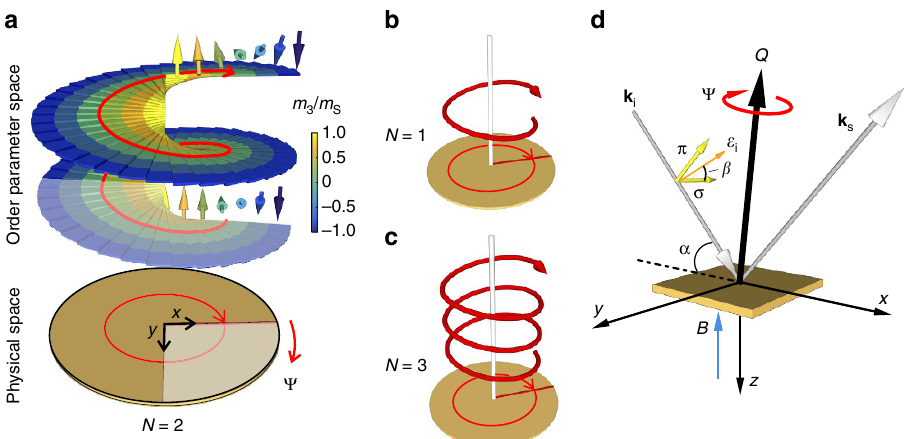
Figure 1 | Concept of winding number and experimental setup. ( a ) For classical spins in two-dimensional space, the spin configuration that carries a winding number of N , as described by equation (1), can be equivalently constructed by mapping the two-dimensional physical space using one-dimensional helices. In order parameter space, the one-dimensional helices are rotated azimuthally by N C from the base position (see, for example, bottom spin helix for C ¼ 0 (cid:2) ), and projected onto physical space at the azimuthal position C . The helices are stacked up in order parameter space for illustrative purposes following the red helical guideline. The example shows the situation for N ¼ 2 where the order parameter space maps the physical space twice. The shaded quarter-circle in physical space (below) corresponds to a covered half-circle in order parameter space (above). Simplified plots for the N ¼ 1 and N ¼ 3 cases are shown in b , c , respectively. ( d ) When C covers the range from 0 (cid:2) to 360 (cid:2) , the scattered intensity will exhibit a periodicity that only depends on N . Both circularly or linearly polarized incident light is used, allowing for two measurement strategies: CD plots and PAMs. In both cases, the diffraction condition is met for the wavevector Q , which contains the topological motif’s modulation wavevector for different azimuthal angles C . The polarization angle b of the incident light polarization vector E i is defined with respect to s -polarization ( b ¼ 0 (cid:2) ; b ¼ 90 (cid:2) corresponds to p